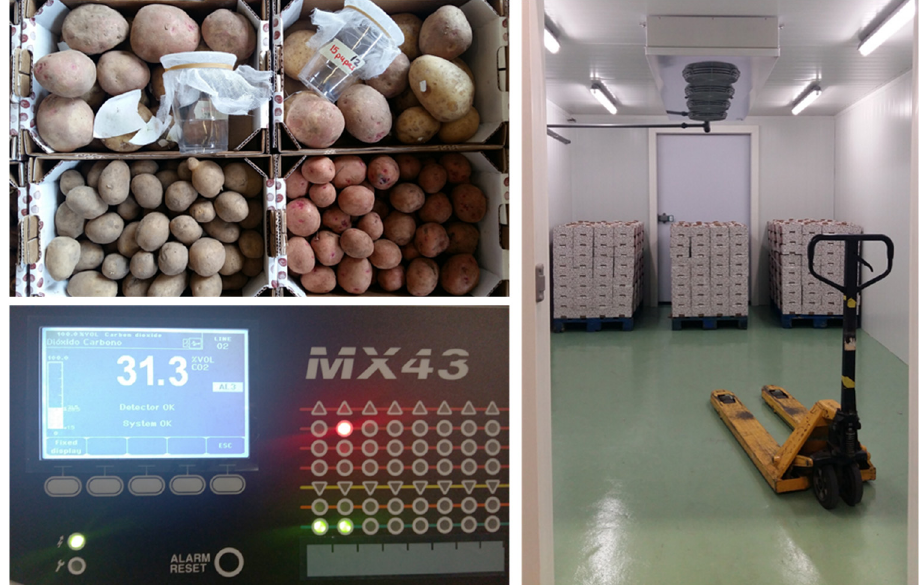
Figure 2. Commercial trial. Pallet preparation using inoculated potatoes with eggs and larvae, pupae, and adults in cylindrical vases, and one box of healthy and another of infested potatoes classified by the farmer. Photos: M.G. Lobo.